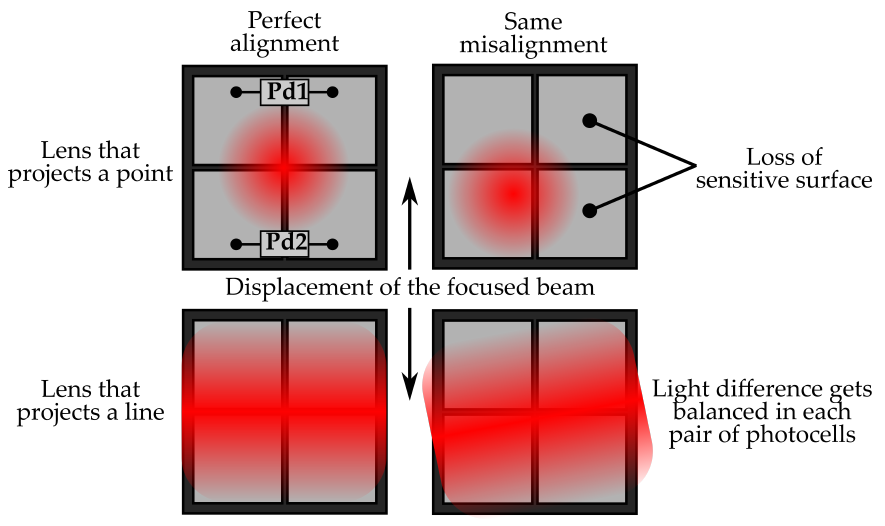
Figure 3. Scheme that shows the light focused by a lens in a 2 × 2 photo-detector matrix and the effect that the misalignment of the optical train produces in the light